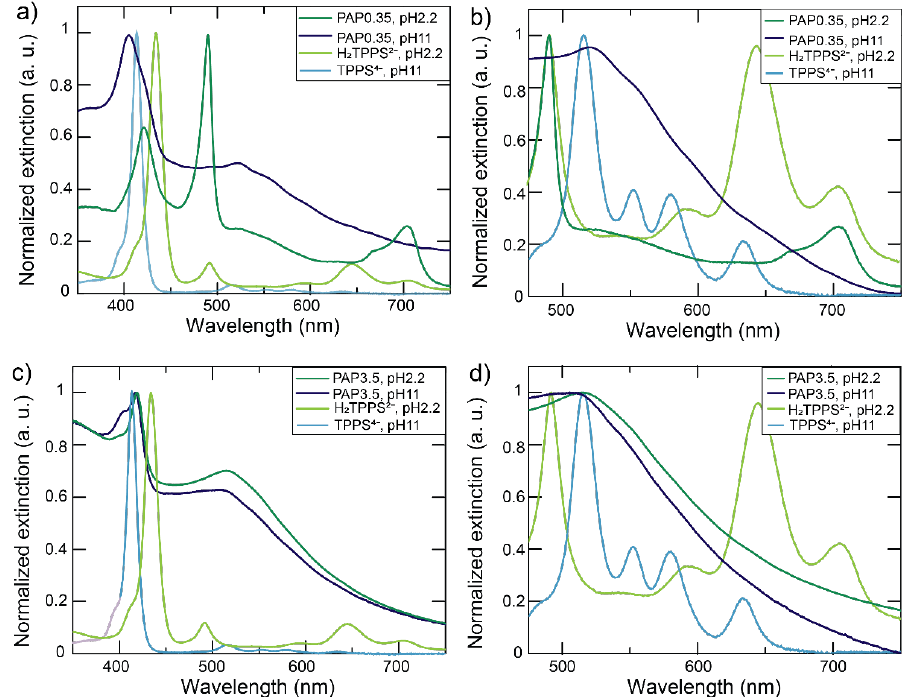
Figure 3. Overall perspective of the extinction spectra of SNPs. Normalized extinction spectra of SNPs, H 2 TPPS 2− (pH = 2.2), and TPPS 4− (pH = 11) at ( a ) PAP = 0.35 and ( c ) 3.5 nm 2 . A zoom of the 480 – 750 nm region of each plot is reported in panel ( b ) and ( d ), respectively.